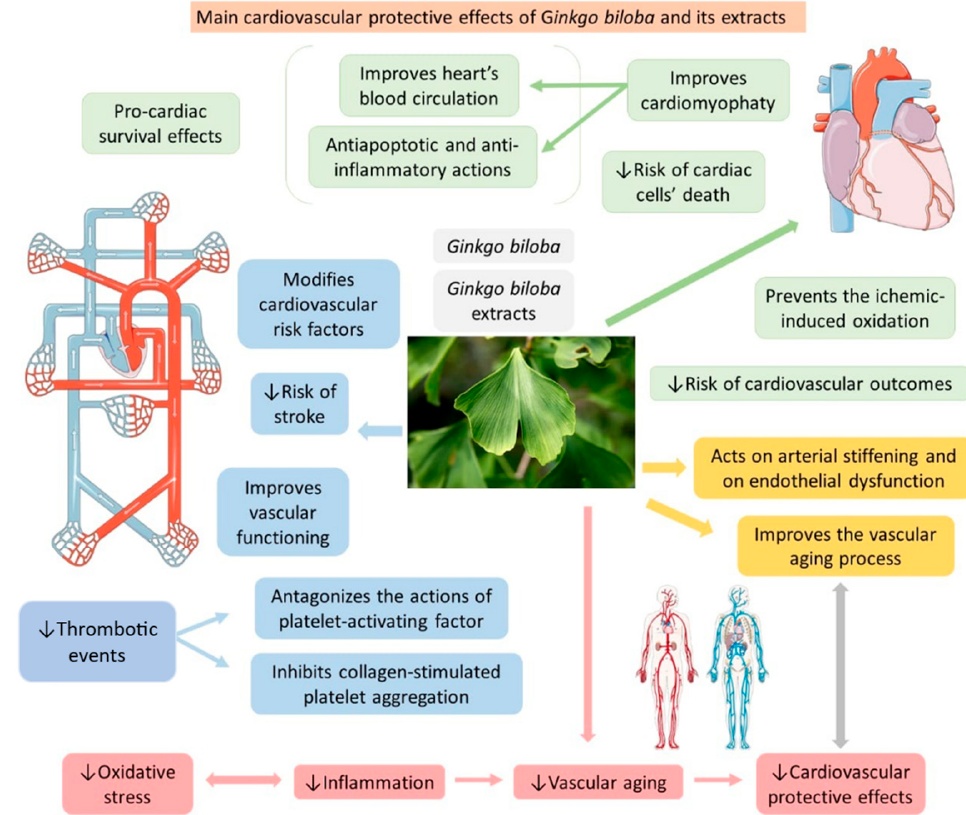
Figure 5. Ginkgo biloba and its extracts have cardiovascular protective effects that improve the functionality of the cardiovascular organs. ↓ —decrease.